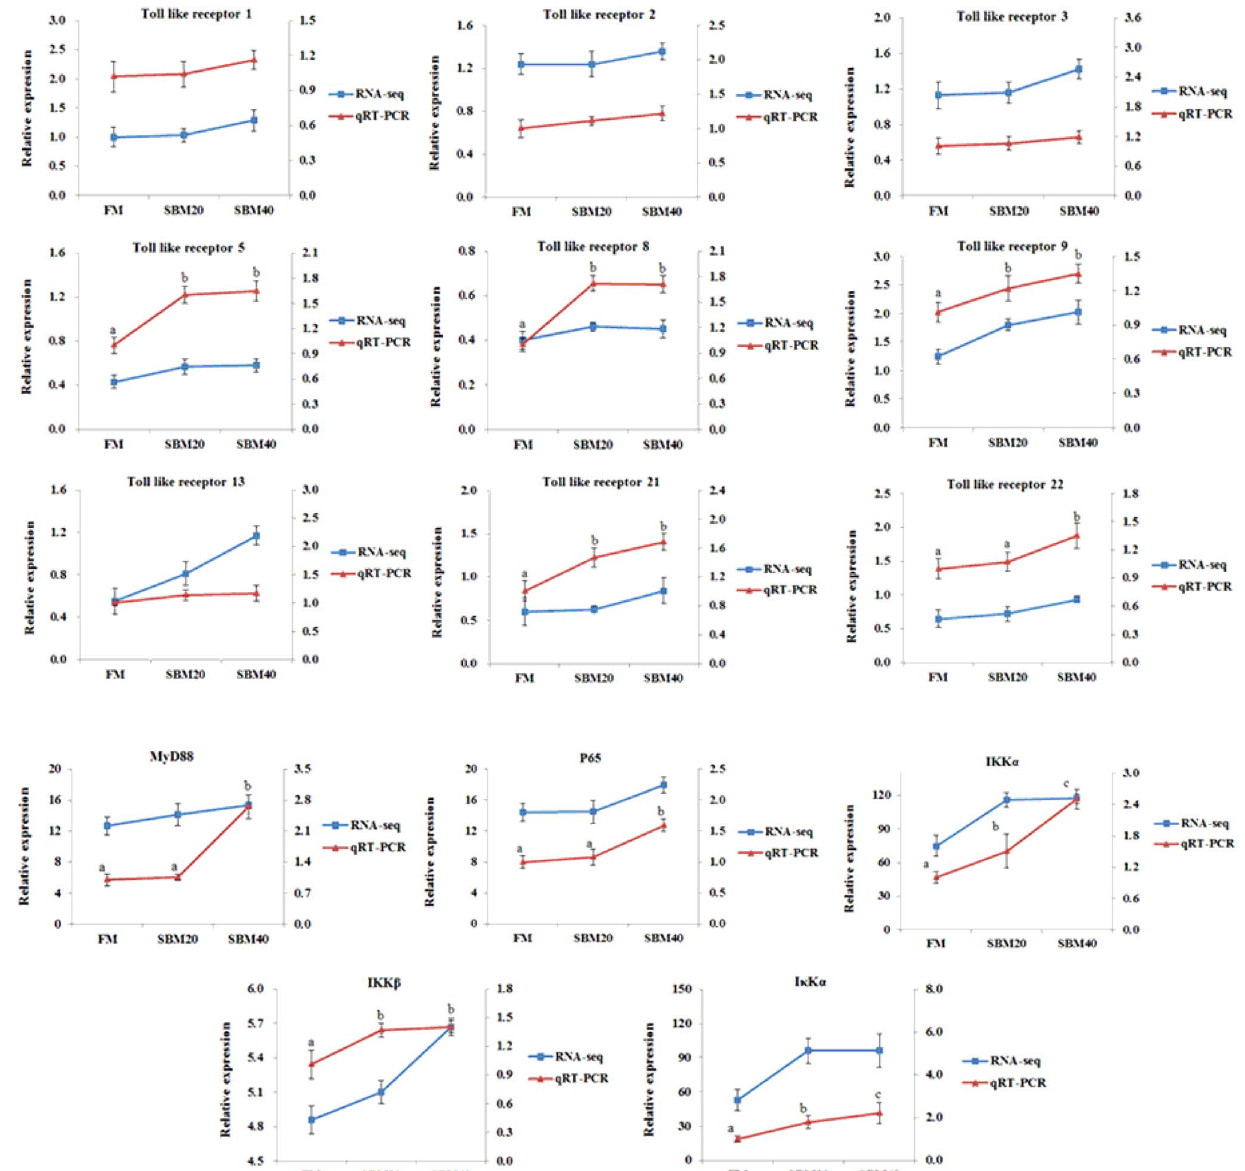
Figure 12. Comparison of RNA Seq and RT-qPCR results (n = 4). Note: in order to validate RNA-seq data, RT-qPCR was used to detect the gene expression level of the TLR-myD88-NF-κB pathway in DI tissue of pearl gentian grouper. The mRNA expression level of RT-qPCR was normalized by β -actin. The relative expression level in RNA-seq analysis was calculated by the FPKM value. The statistical results are expressed as mean ± SD. Different letters assigned to the lines represent significant differences between the groups at P < 0.05. FM, fish meal control group; SBM20, 20% SBM protein replacement level to FM protein; SBM40, 40% SBM protein replacement level to FM